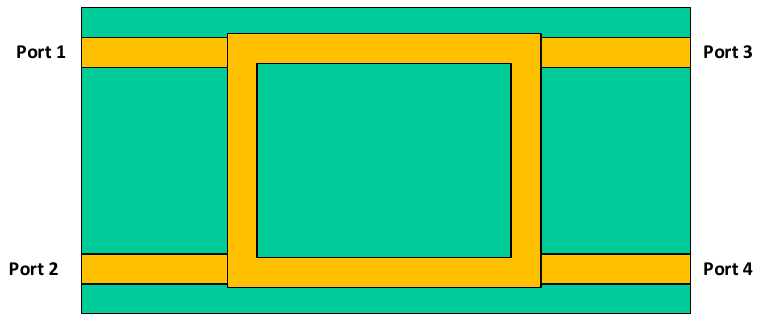
Figure 1. Diagram of the tunable branch line coupler (BLC).